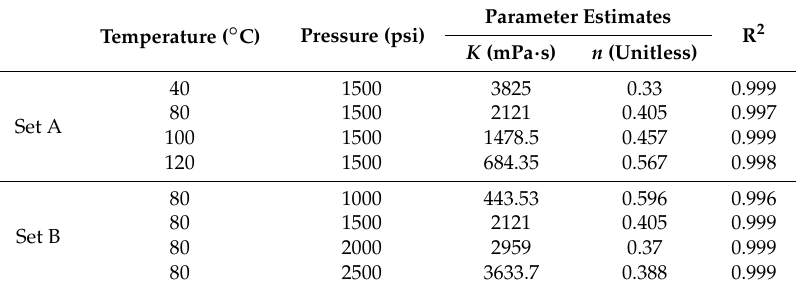
Table 1. Parametric estimates of the power law model for sCO 2